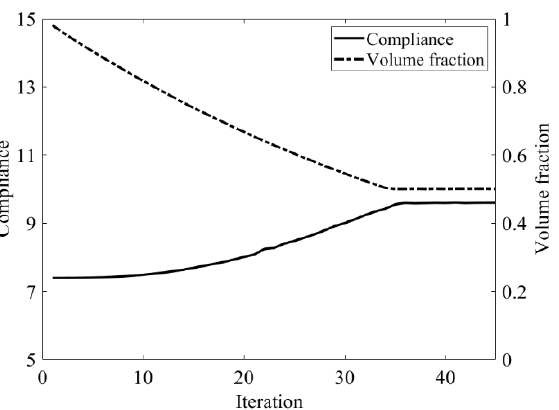
Figure 8. Convergence history of the compliance and volume fraction for two-dimensional simple bridge beam by the improved method.